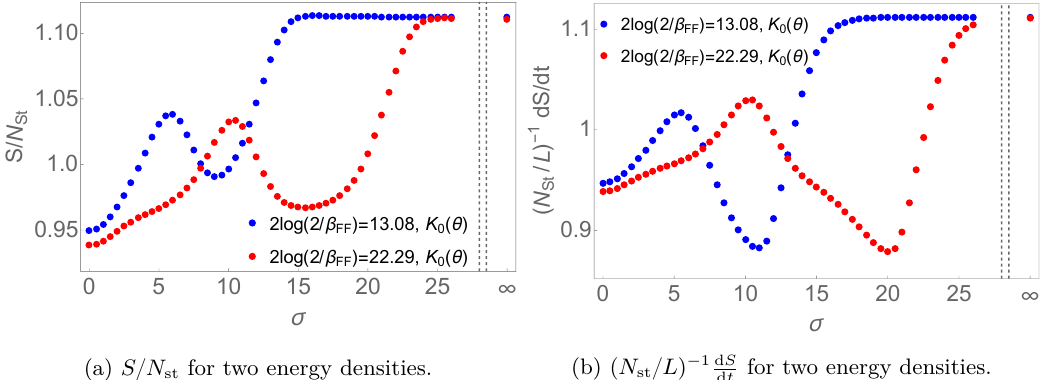
Figure 13 . The total thermodynamic entropy density S { N st (a) with respect to the total particle number and the entropy production rate divided by the particle number density p N (b) against σ after quenches characterised by K and fixed injected energy density. The blue 0 p θ q dots correspond to 2 log 2 { β 13 . 08 or β 2 . 8944 ˆ 10 ´ 3 (left axis) and the red dots to FF “ FF “ 2 log 2 { β 22 . 29 or β 2 . 8944 ˆ 10 ´ 5 (right FF “ FF “